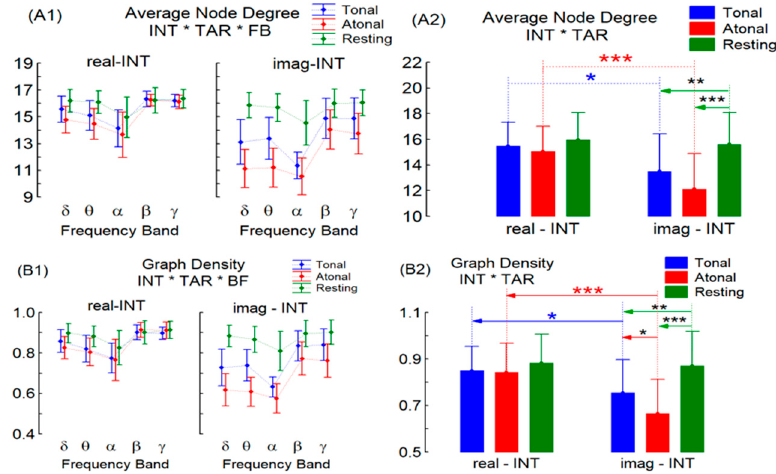
Figure 1. Mean values (95% confidence interval) for the average node degree ( A1 , A2 ) and graph density ( B1 , B2 ) of the EEG graph/network. On the left side ( A1 , B1 ), the cross interactions (INT * TAR * FB) between the two INT performance modes (real-INT and imag-INT), the 5 frequency bands FB (delta- δ , theta- δ , alpha- δ , beta- δ , and gamma- γ ) and the 3 musical conditions (tonal, atonal music, and rest) can be visualized. In the right column ( A2 , B2 ) the INT * TAR cross-interactions (irrespective of FB) between real-INT/imag-INT and the 3 musical conditions are shown. Asterisks * are for the significance levels of the posteriori comparisons between pairs of repeated factors (* for p < 0.05, ** for p < 0.01, and *** for p < 0.001).